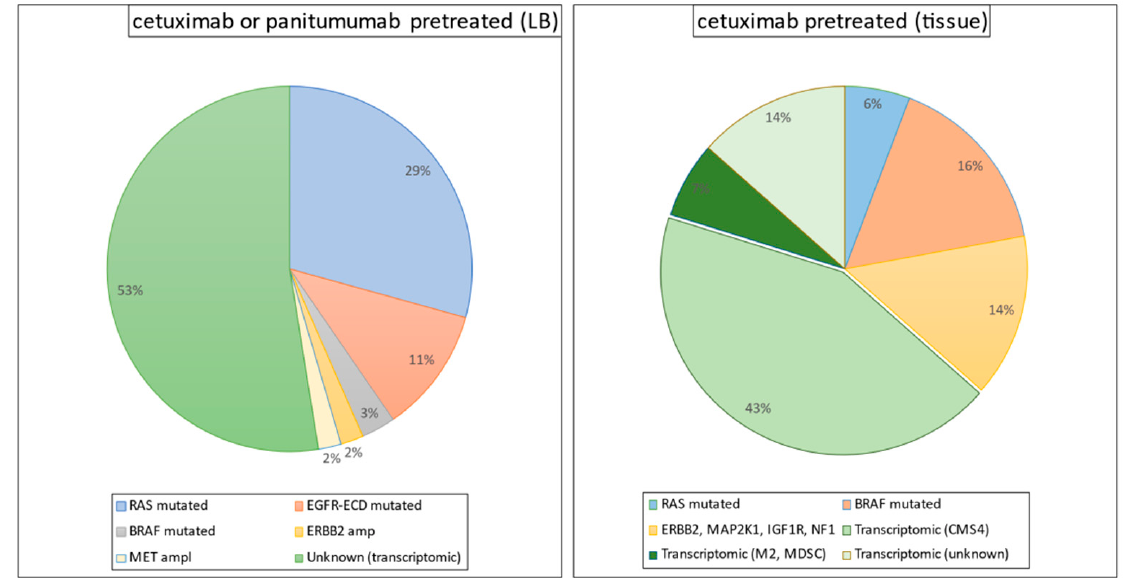
Figure 1. Mutation profile in biopsy and liquid biopsy (LB) samples from pretreated colorectal patients with KRAS, NRAS, and BRAF wild-type.